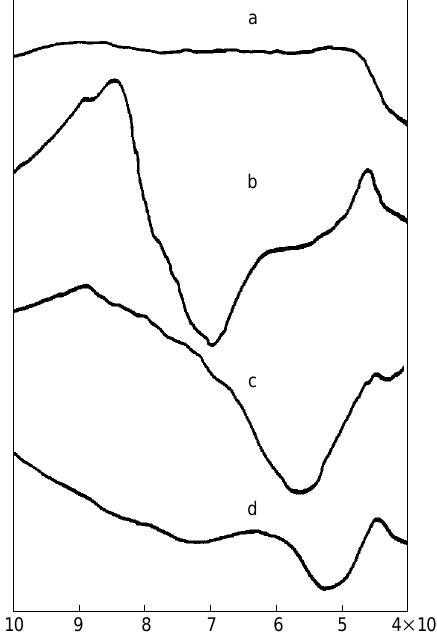
Fig. 14 IR spectra of (a) an initial mixture of barium peroxide with metals and after 1 min. mechanical activation: (b) - Ti, (c) - Zr, (d) - Al.